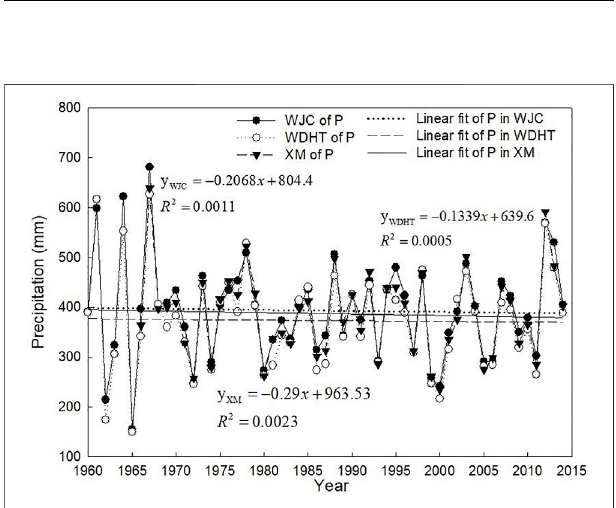
FIGURE5 | The variation in P inthe Kuye River basin during